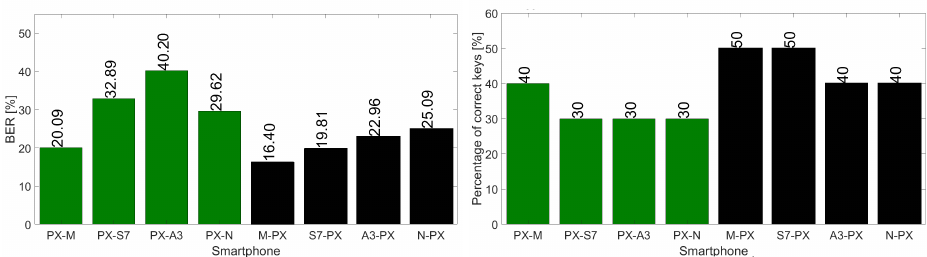
Figure 15. The BER ( left ) and the percentage of correct keys ( right ) for the measurements with the infotainment unit with environmental noise; marked with green when receiver app running on PX5 infotainment unit and with black when the receiver app in running on the